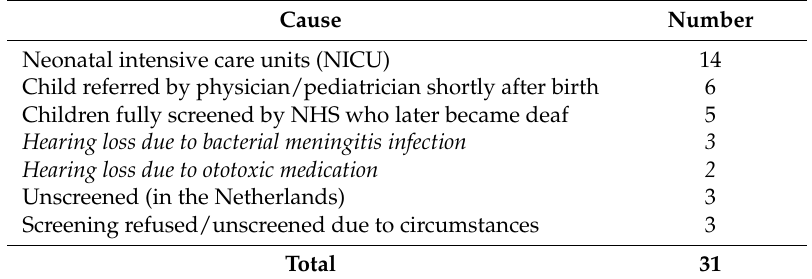
Table 5. Children not detected by neonatal hearing screening (NHS) under early intervention. Cause Number Neonatal intensive care units (NICU) 14 Child referred by physician/pediatrician shortly after birth 6 Children fully screened by NHS who later became deaf 5 Hearing loss due to bacterial meningitis infection 3 Hearing loss due to ototoxic medication 2 Unscreened (in the